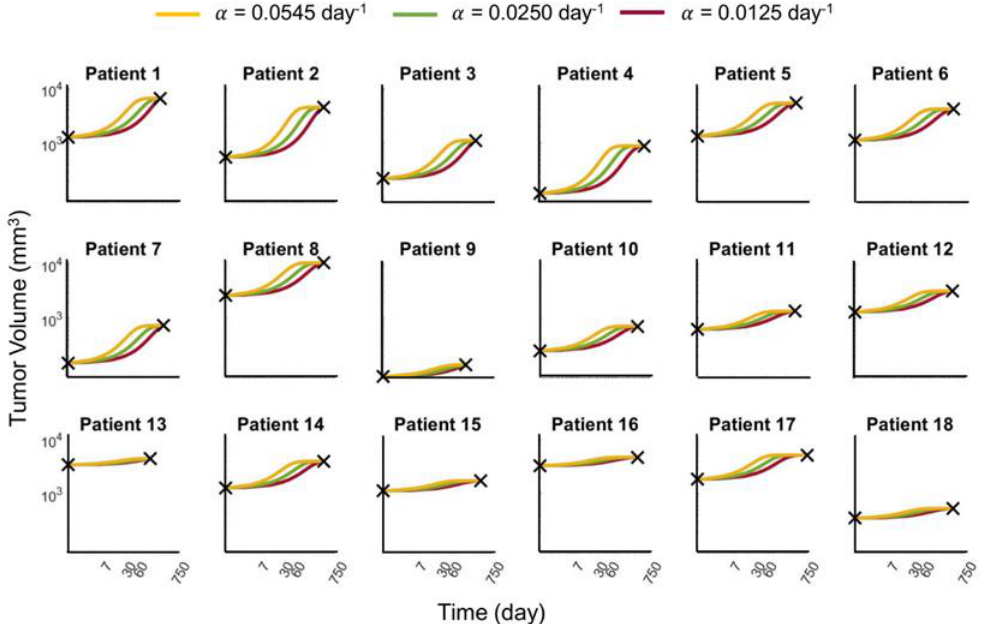
Figure 2. Logistic tumor growth curves of 18 untreated breast cancer patients. The black × markers denote the initial and final tumor volumes abstracted from clinical measurements. Three different curves were fitted through these two data points; each corresponds to the different growth rates of 𝛼 = 0.0125 day −1 , 0.025 day −1 , and 0.0545 day −1 (red, green, and yellow curves, respectively) uniformly for all 18 patients. For easy comparison across the patient population, all curves are plotted on the same log-log scale with tumor volumes ranging from 80 to 11,000 mm 3 , and time ranging from zero to 750 days.